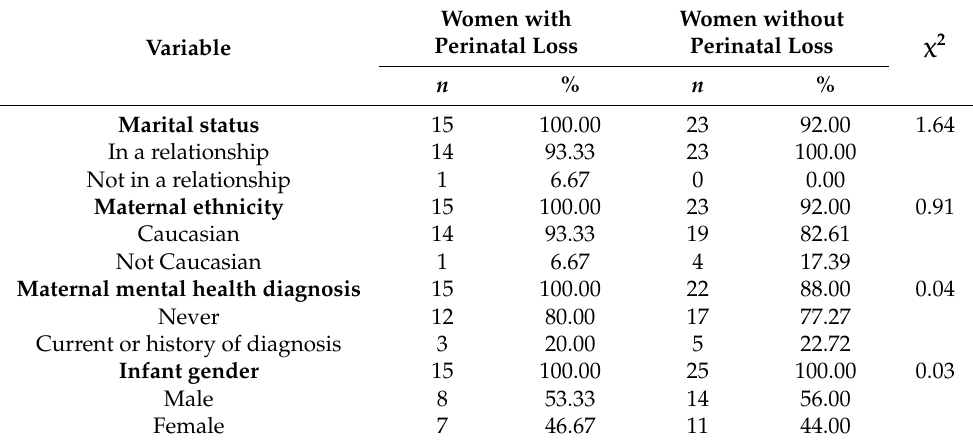
Women with Women without Perinatal Loss Perinatal Loss